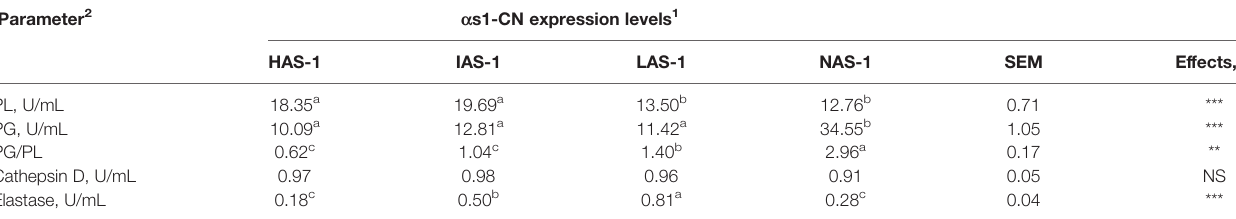
TABLE 4 | Effect of different a s-1 casein expression levels on milk indigenous proteolytic enzymes. Parameter